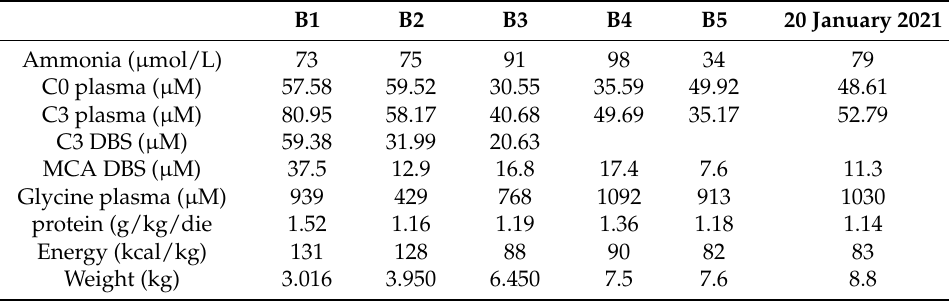
Table 1. Biochemical, growth, and nutritional